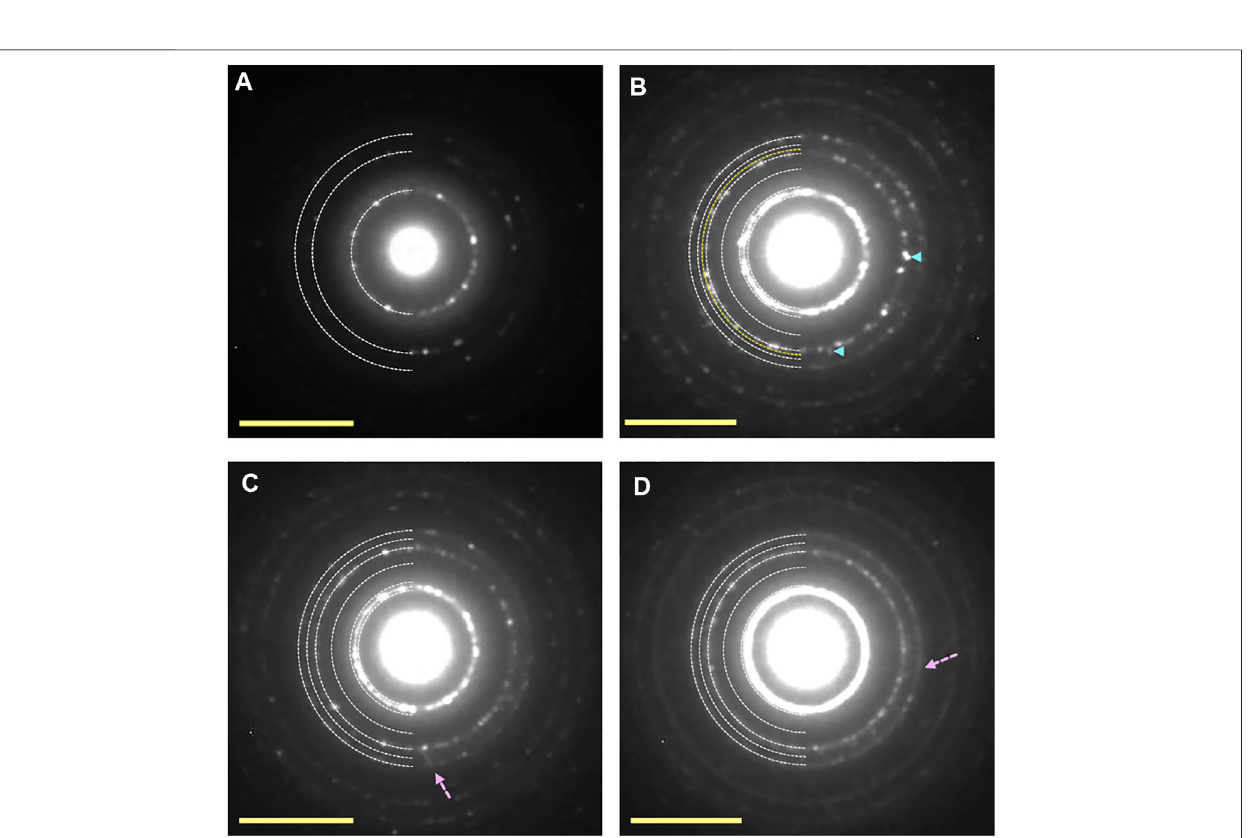
FIGURE 8 | Electron diffraction patterns of ice Ic samples before and after UV-irradiation. (A) Crystalline islands of ice Ic deposited at 140 K. (B – D) Ice samples exposed to UV dose of ∼ 2 × 10 17 photons cm − 2 at 83, 100, and 120 K, respectively. The appearance of additional diffraction spots shown by pale blue arrow heads in (B) canbeindexedasthe131diffractionoficeXI.AlthoughtheappearanceofadditionaldiffractionspotsfromiceIhwasobservedat100and120 K,thatfromiceXIwas not observed. Some streaks caused by the formation of stacking faults shown by pink broken arrows were observed. Yellow scale bars, 5 nm − 1 .